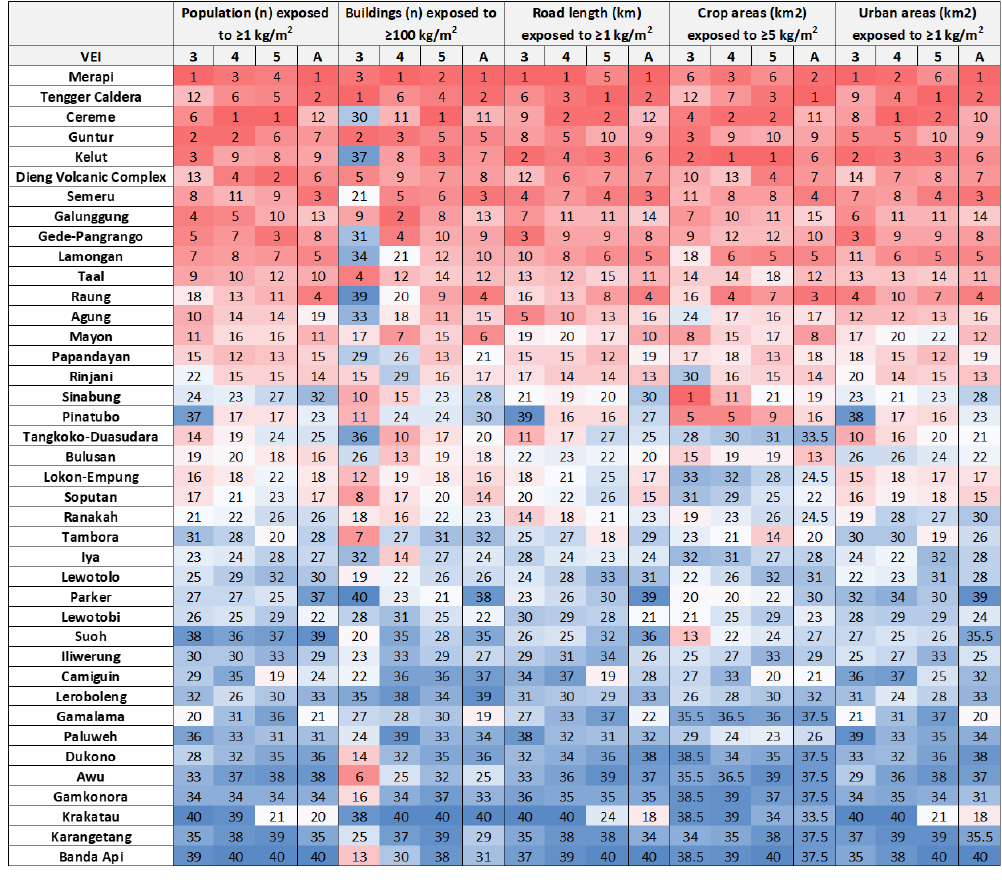
Figure 12. Individual rankings for calculated exposure using the 50% tephra fall hazard for all volcanoes across the five exposure categories. Columns “3”, “4” and “5” quantify the exposure to the conditional occurrence of VEI 3, 4 and 5 scenarios. Column “A” quantifies the absolute exposure using the sum of all scenarios, in which each scenario was weighted by its probability of occurrence. For each individual column, all volcanoes are attributed a rank between 1 and 40, where 1 is considered the highest (i.e. the largest exposure; dark red cells) and 40 the lowest (dark blue cells). Volcanoes are ordered from highest to lowest ranking across all conditional categories (equal weighting assumed). For instance, Raung volcano is the 11th ranked volcano for population exposure to ≥ 1kgm − 2 when considering a VEI 5 eruption (with the highest and lowest being Cereme and Banda Api, respectively) but is amongst the volcanoes with the lowest rank (39) for building exposure to 100kgm − 2 when considering a VEI 3